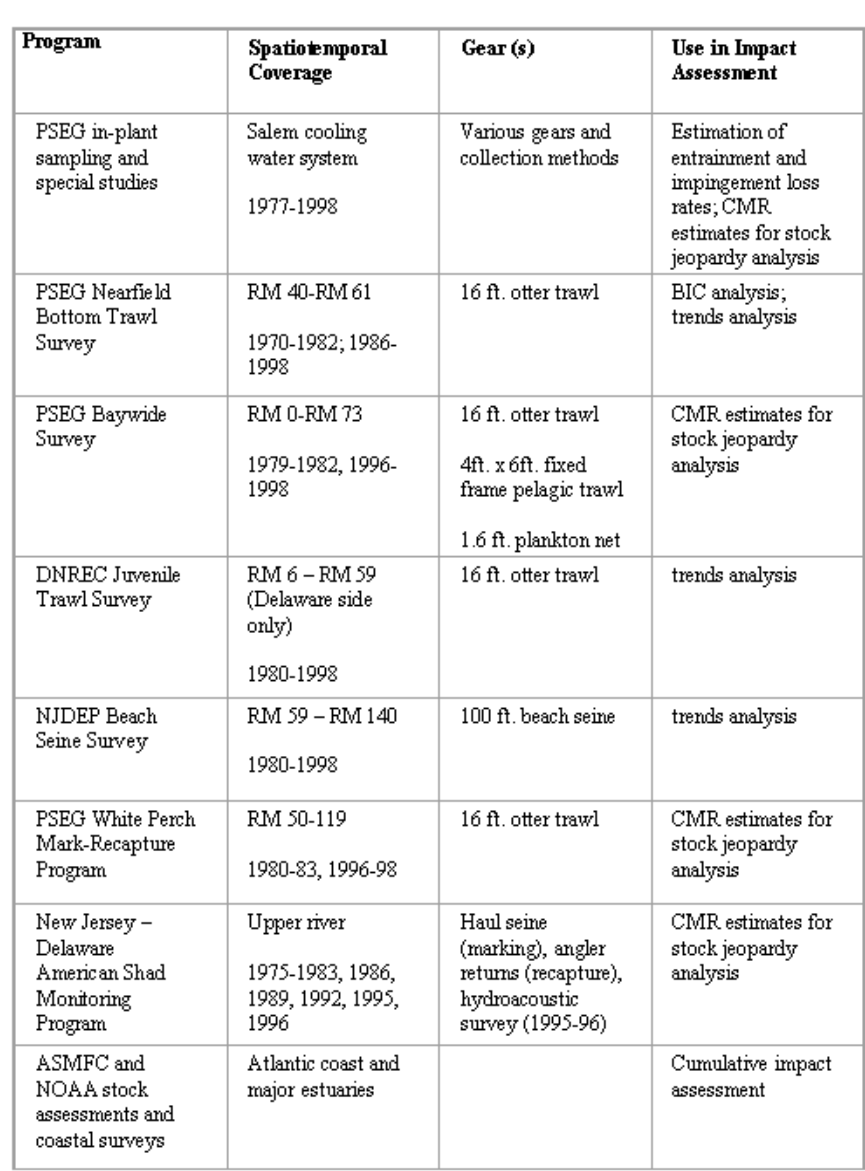
Sampling Programs Used to Assess Impacts of Salem on Delaware Estuary Fish Populations and